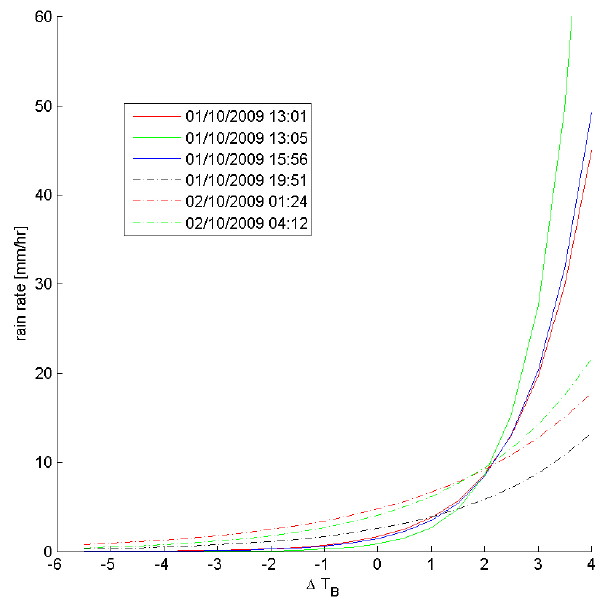
Fig. 7. Calibration functions for the main storm of previous Figs. 4 and 5, corresponding to the 6 different AMSU overpasses indicated in the